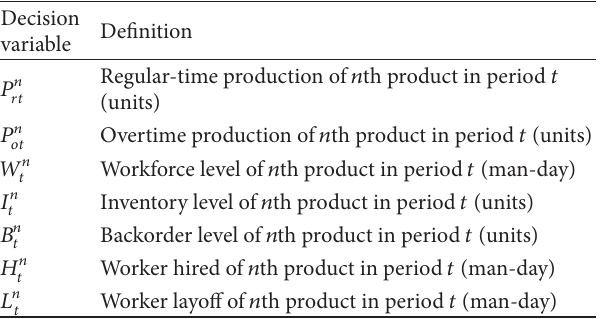
Table 1: Notation for decision variables of the fuzzy APP